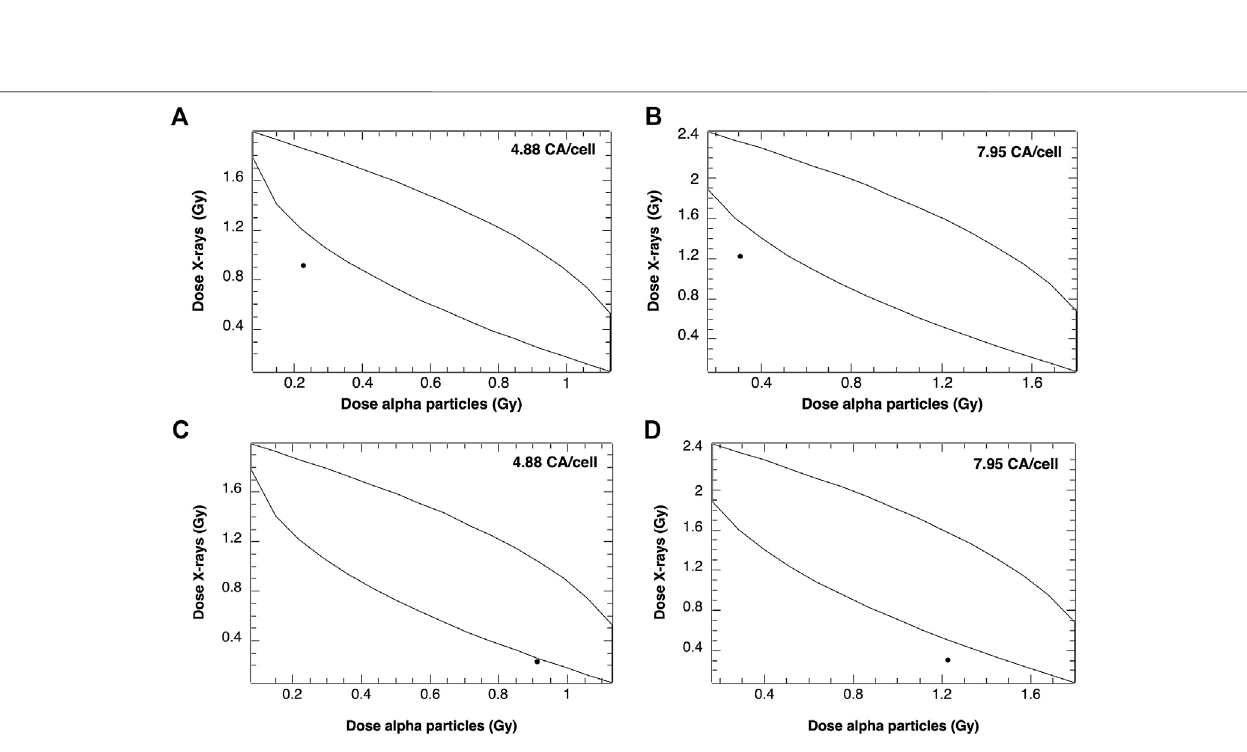
Frontiers in Physics |